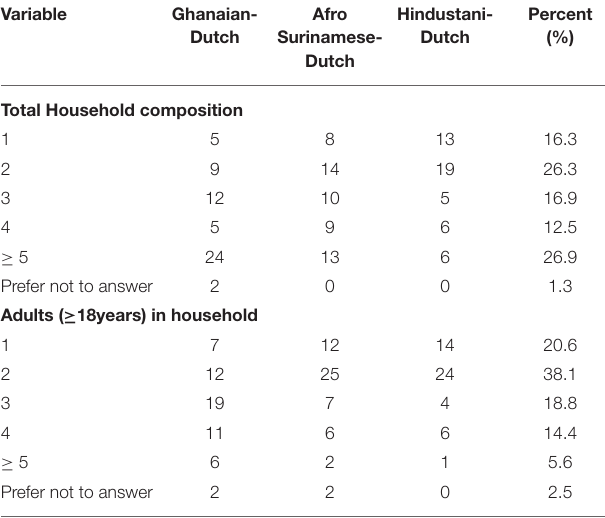
TABLE 2 | Household characteristics of study respondents.